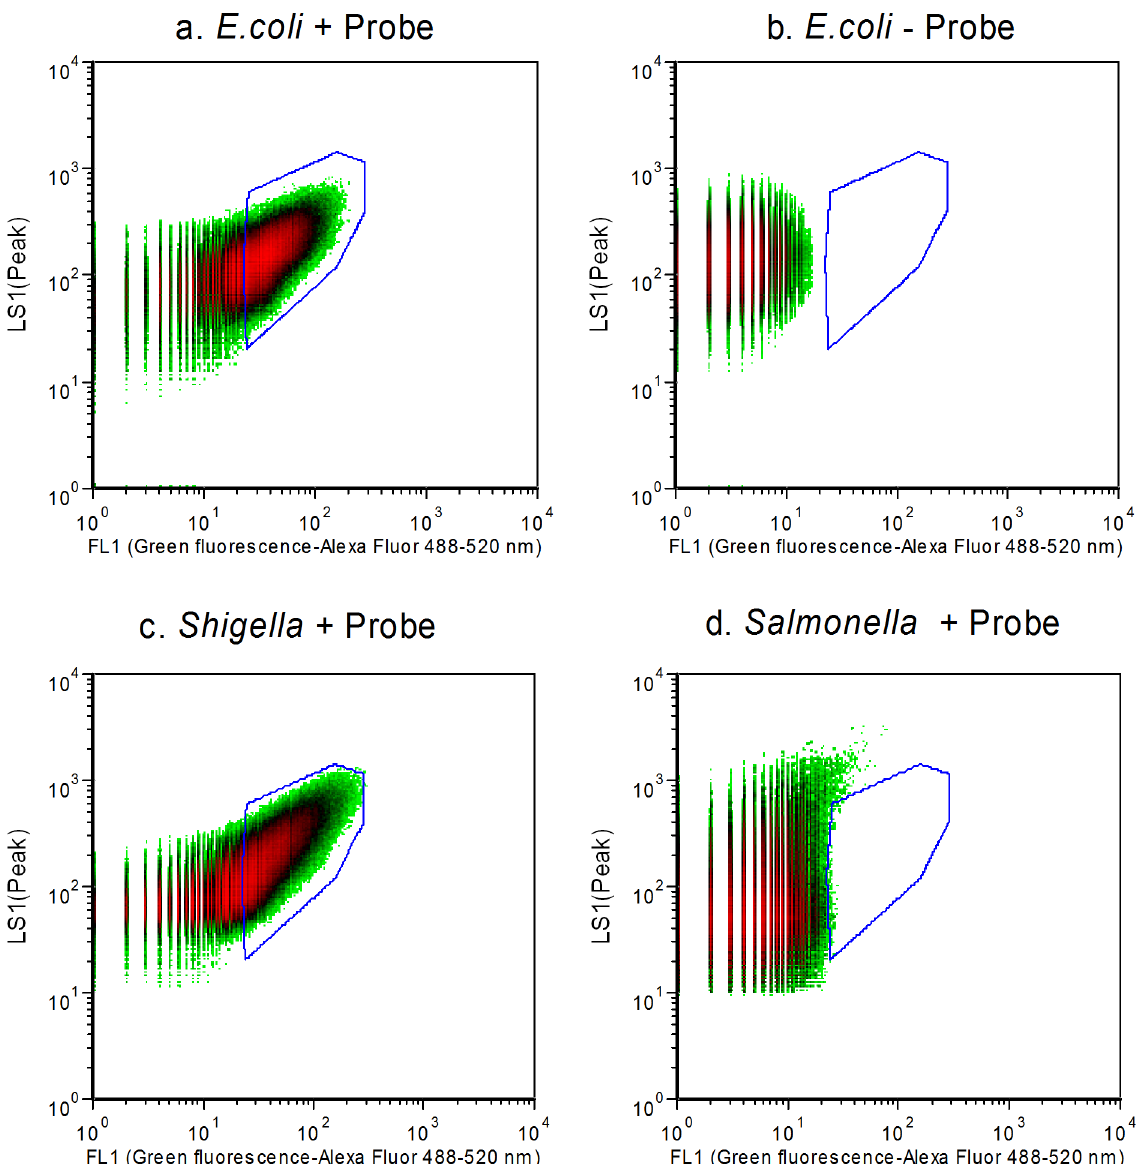
Fig 4. Flow cytometry density-plot of pure cultures hybridized with ES445 probe. LS1: side scatter, FL1: green fluorescence-Alexa Fluor 488 – 520 nm. A. E . coli O157 + Probe ES445-Alex; b. E . coli O157 — Probe ES445-Alex; c. Shigella flexneri + Probe ES445-Alex; d. Salmonella enterica serovar choleraesuis + Probe